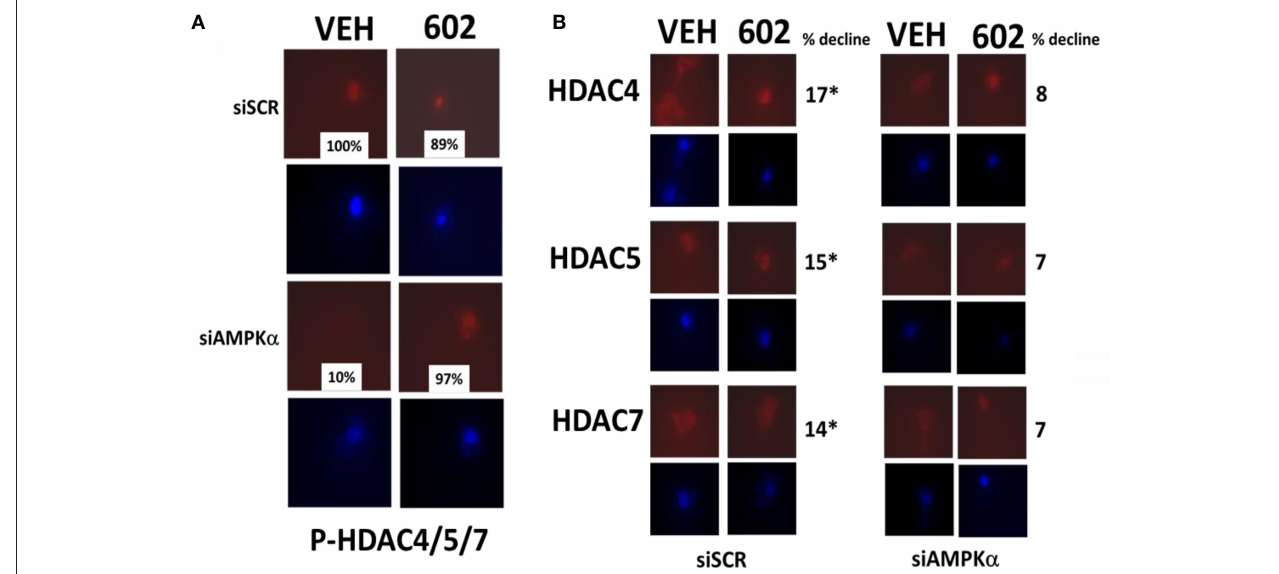
FIGURE 9 | GZ17-6.02 regulates the expression and location of HDACs. (A,B) HT1080 cells were transfected with a scrambled siRNA (siSCR) or with an siRNA to knock down the expression of AMPK α . Twenty-four hour afterwards, cells treated with vehicle control or with [GZ17-6.02 (2 µ M final curcumin) 1h. Cells were fixed in place and immunostaining performed to detect the expression of HDACs4/5/7 and P-HDACs4/5/7 and total ERK2 ( n = 3 + /–SD). * p < 0.05 less than vehicle control ( n = 3 + /–SD). * p < 0.05 less than vehicle control.